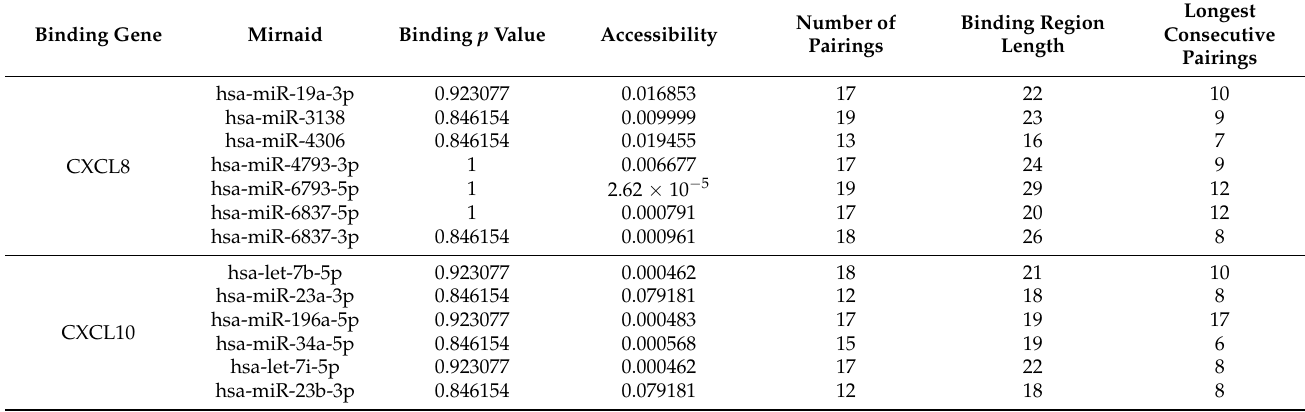
Table 5. Downregulated miRNAs binding with CXCL8 and up-regulated miRNAs binding with CXCL10. Binding